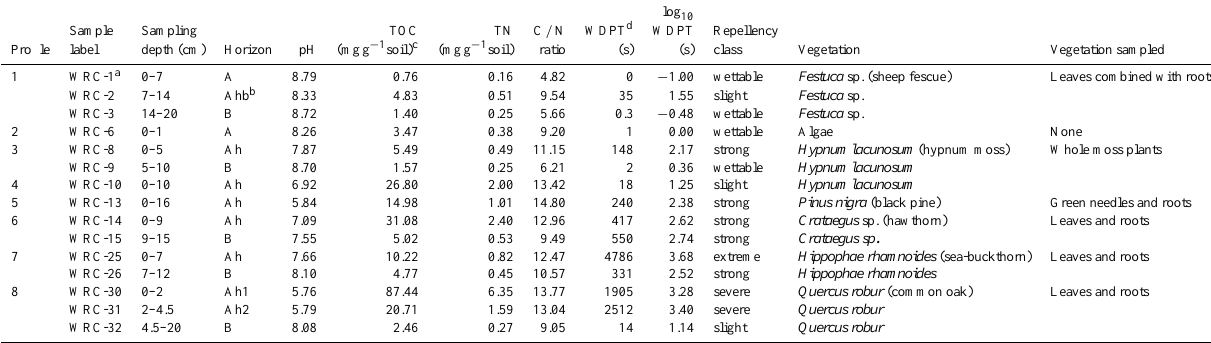
Table 1. Soil profile and vegetation description. Sample Sampling